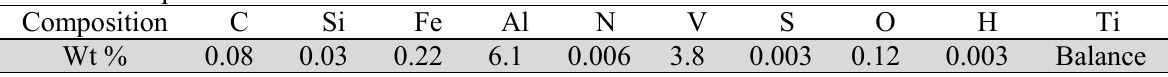
Chemical composition of Ti6Al4V